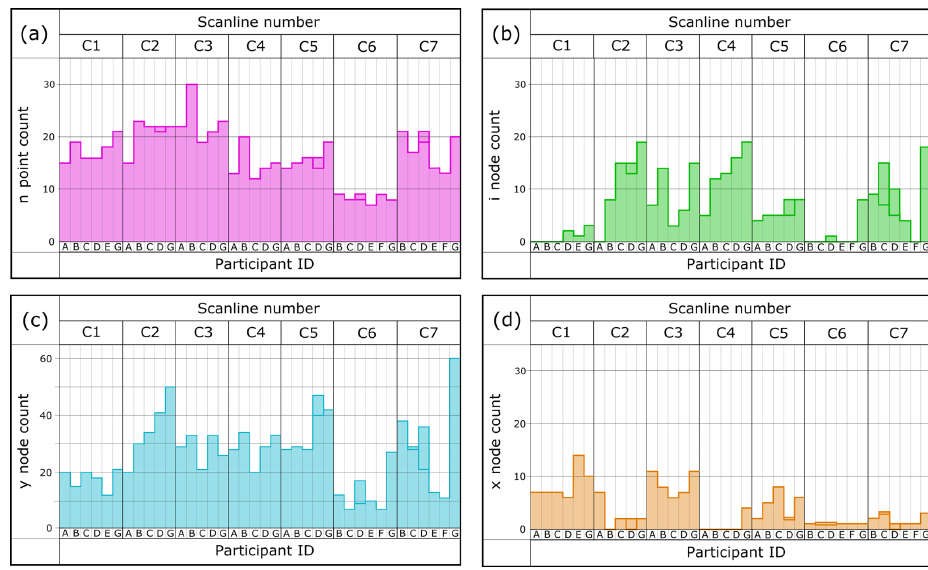
Figure 3. Results of the fracture data from circular scanlines (C1–7) collected in the field by seven participants (labelled A–G, though A, E, and F did not complete all of the scanlines). (a) The number of fractures that intersected the circular scanlines ( n ). (b) Fractures that terminated in rock ( i nodes). (c) Fractures that terminated against another fracture ( y nodes). (d) Fractures that intersect another fracture ( x nodes). Participants C and D repeated some of their measurements for selected circles and this is indicated by two bars in their column for that